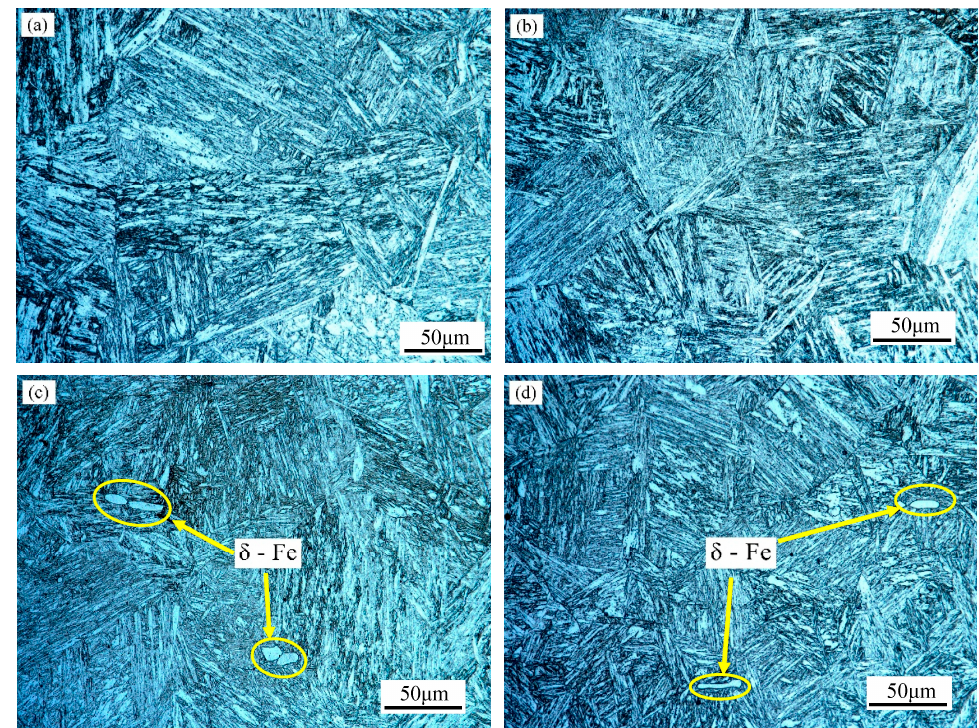
Figure 3. Optical microstructures of the experimental steels after heat treatment ( a ) 1L (low Si and low temperature), ( b ) 1H (low Si and high temperature), ( c ) 2L (high Si and low temperature), and ( d ) 2H (high Si and high temperature).